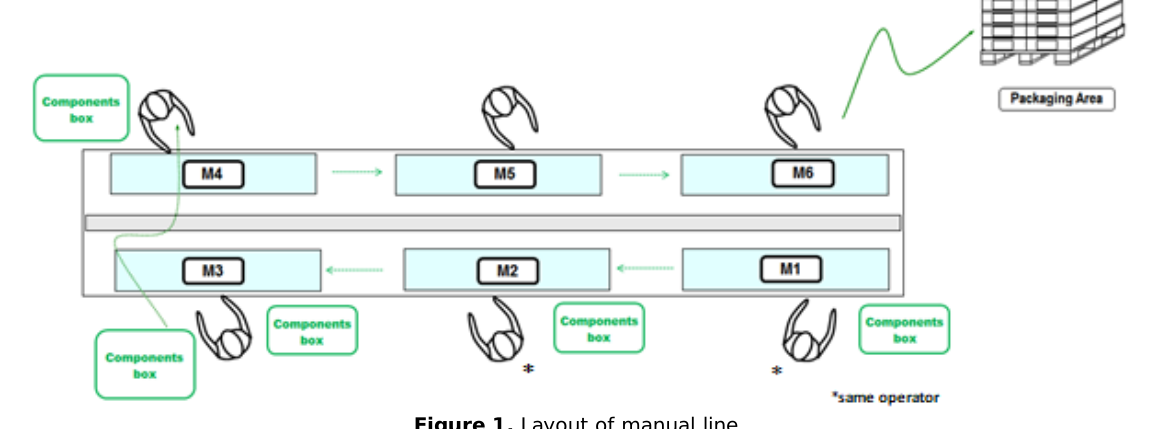
Figure 1. Layout of manual line